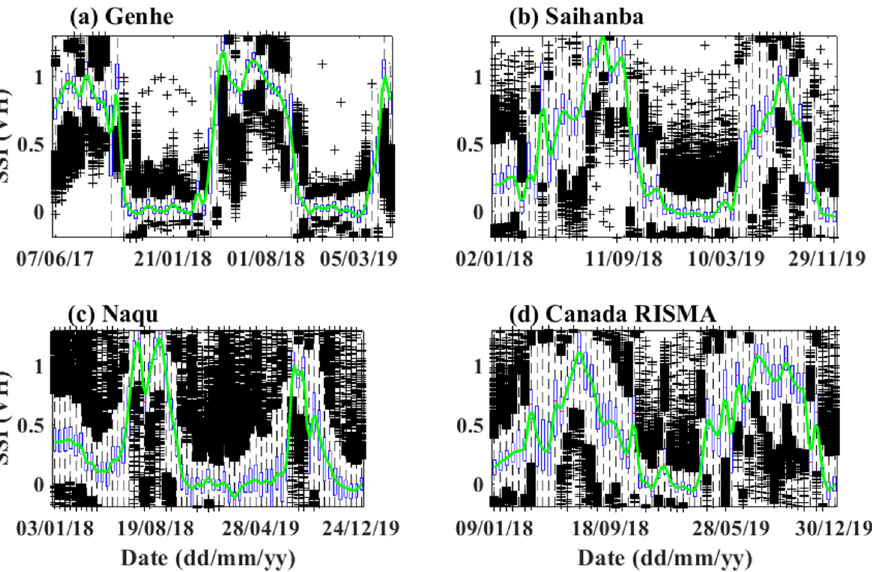
Figure 2. Time series of boxplots of SSI S1 at VH polarization over the Genhe watershed ( a ), Saihanba ( b ), Naqu ( c ), and RISMA ( d ). On each box, the green line indicates the median, and the bottom and top edges of the box indicate the 25th and 75th percentiles, respectively. The whiskers extend to the most extreme data points not considered outliers, and the outliers are plotted individually using the ‘+’ marker symbol in black.